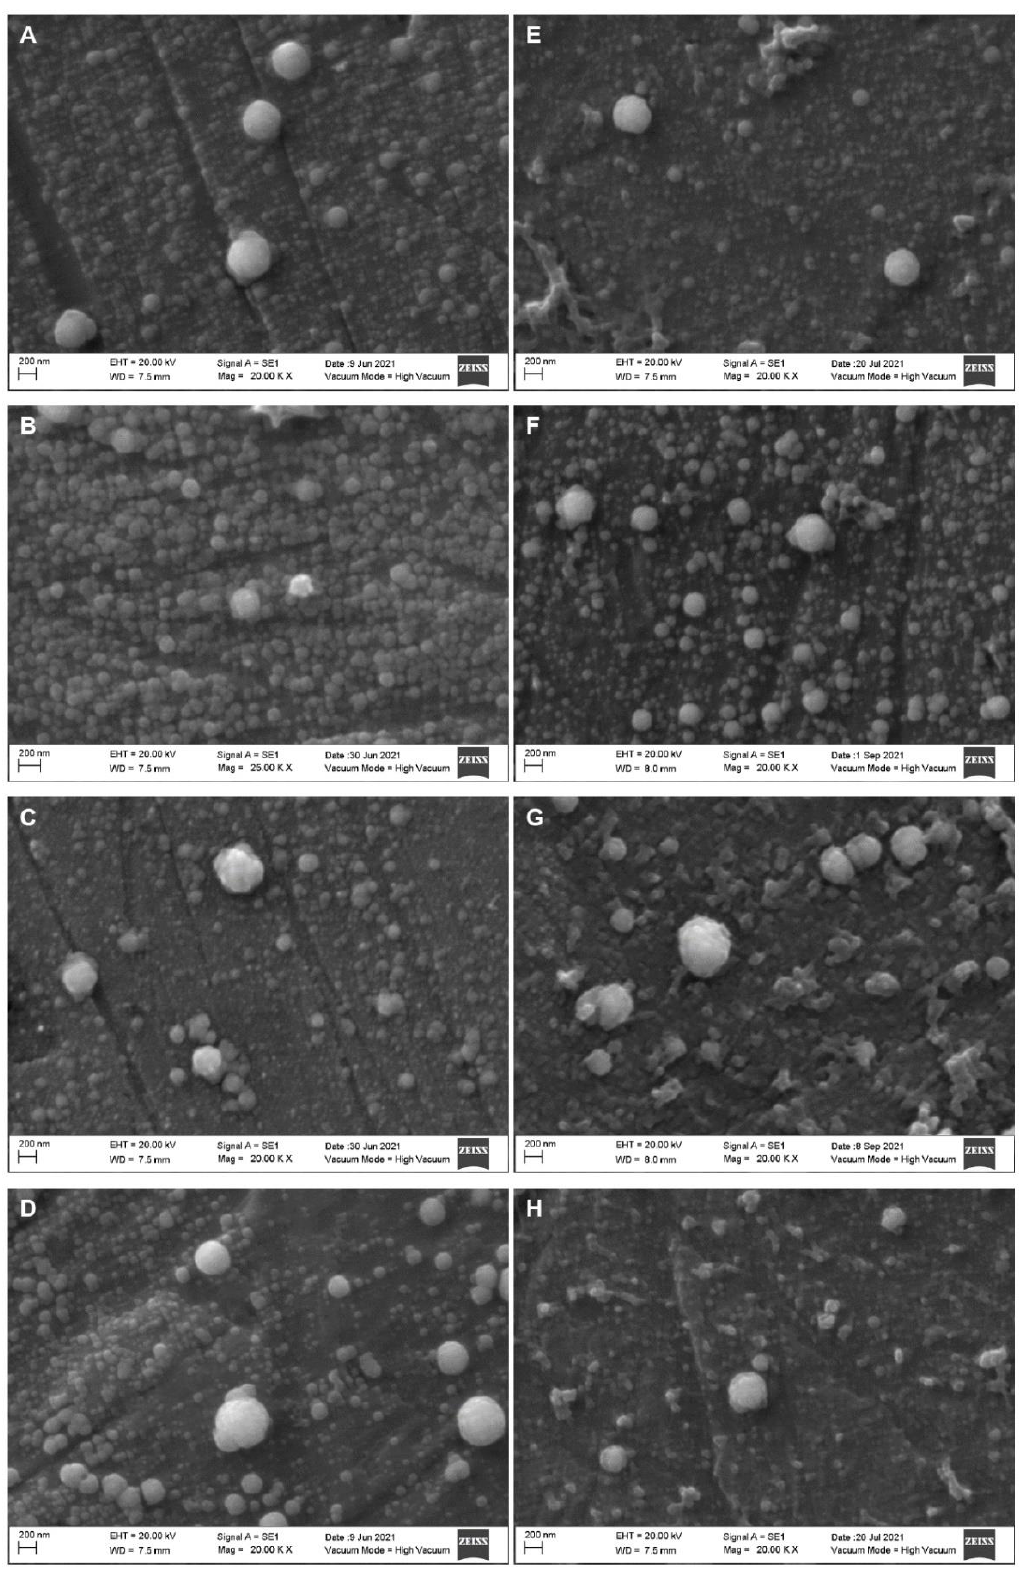
Figure 5. Scanning electron microscopy micrographs of homogenized whole (left column) and skim (right column) milk samples treated at 600 MPa. Come-Up Time ( A , E ); 2 min ( B , F ); 5 min ( C , G ); 10 min ( D , H ).